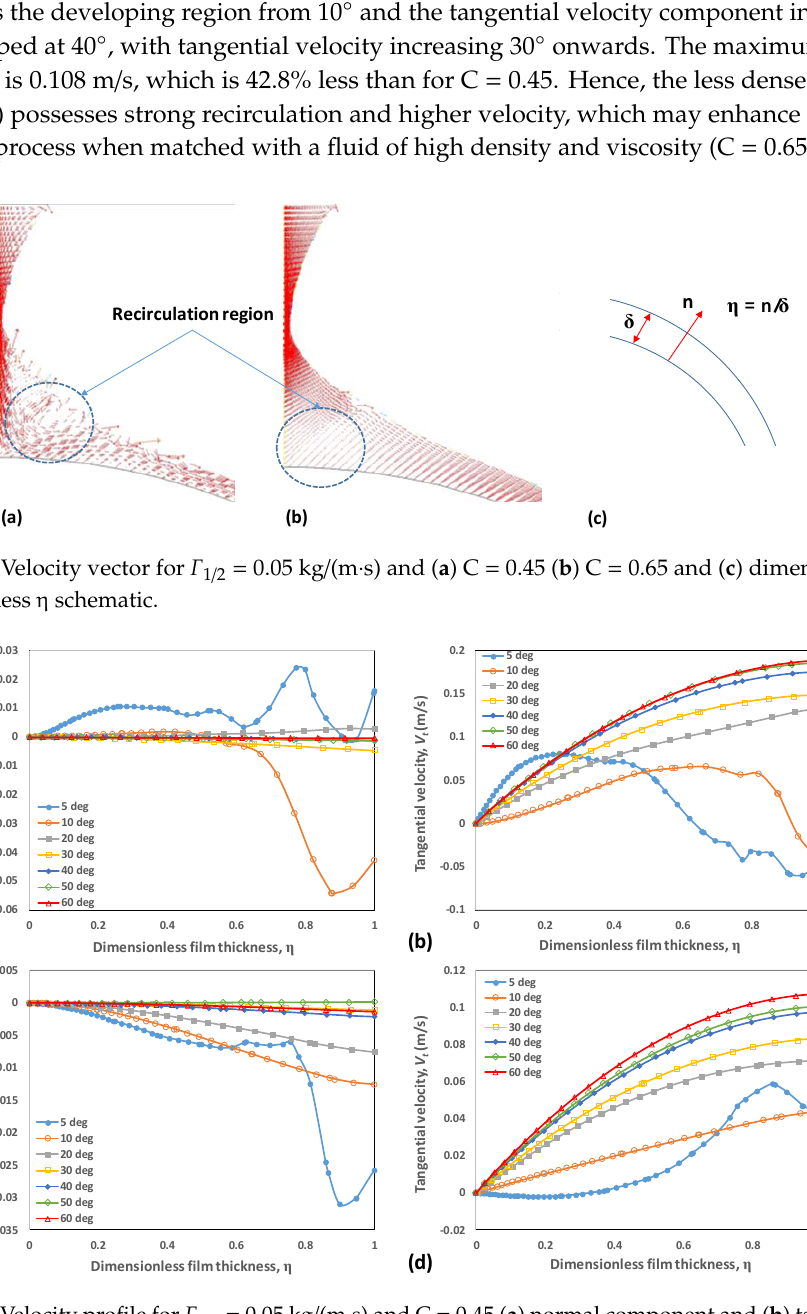
Figure 11. Velocity profile for Γ 1 / 2 = 0.05 kg/(m·s) and C = 0.45 ( a ) normal component and ( b ) tangential component; and for Γ 1 / 2 = 0.05 kg/(m·s) and C = 0.65 ( c ) normal component and ( d ) tangential component.